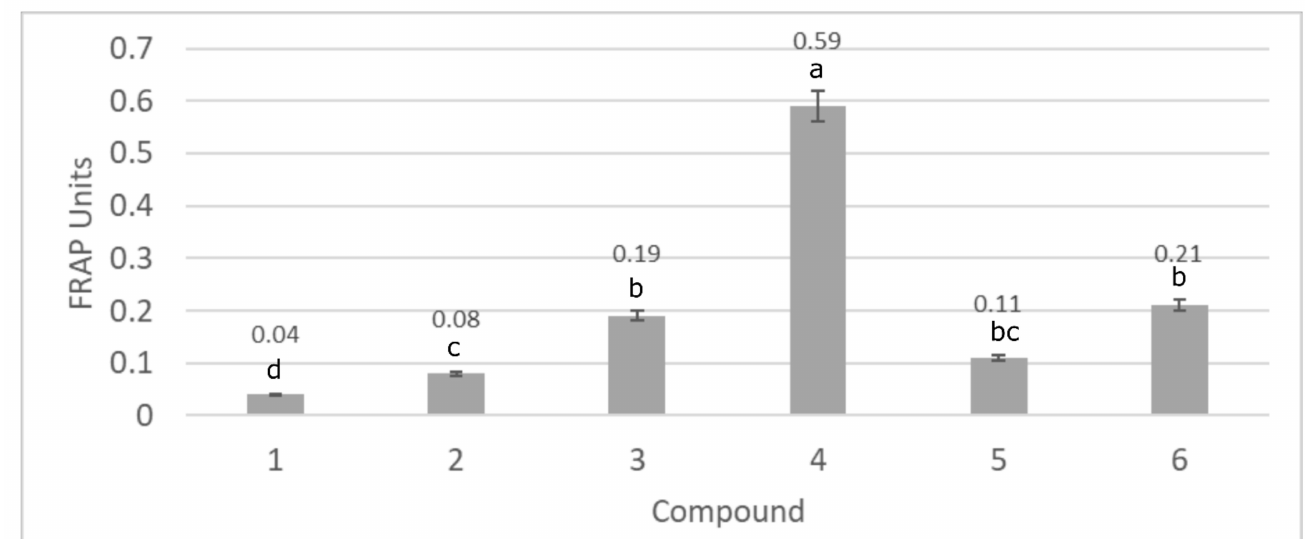
Figure 3. The evaluation of antioxidant activity of lupeol (1) and its new derivatives (2: lupeol acetate, 3: lupeol propionate, 4: lupeol isonicotinate, 5: lupeol succinate, 6: lupeol acetylsalicylate). Data presented as mean values ± SD ( n = 3). Different letters (a–d) indicate significant difference between mean values at p <